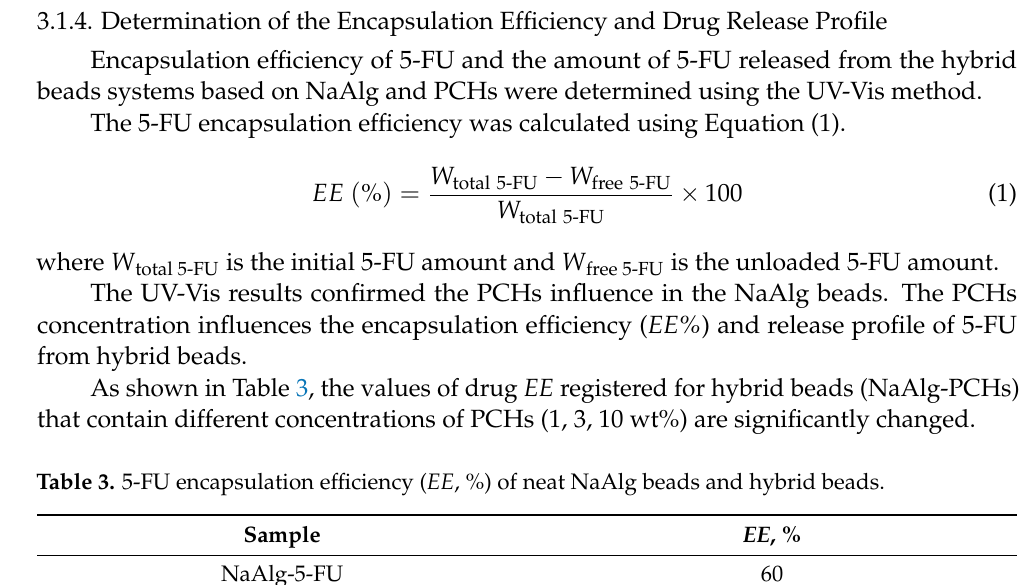
Figure 8. Drug release profiles in SGF (a) and SIF (b) for: 1-NaAlg-5-FU, 2-NaAlg-5-FU-PCHs 10 wt%, 3-NaAlg-5-FU-PCHs 3 wt%, 4-NaAlg-5-FU-PCHs 1 wt%.